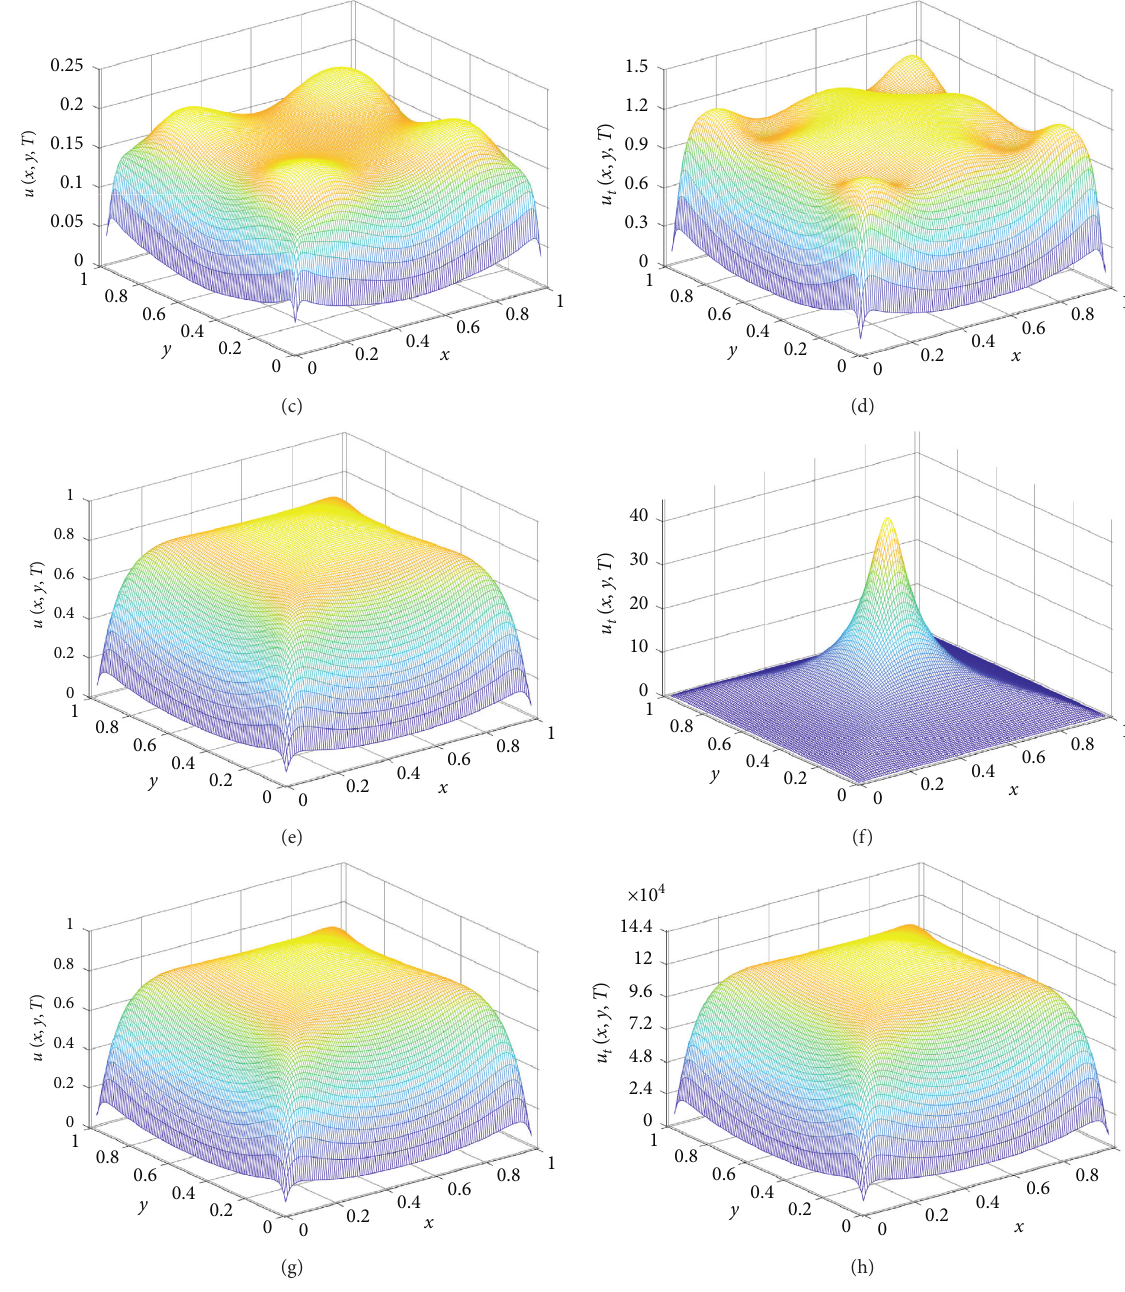
Figure 5: Numerical solution u ( x,y, T ) (a, c, e, g) and its temporal rate of change function u T � 1000 τ ≈ 0 . 00683013, 2000 τ ≈ 0 . 01366026 , 70455 τ ≈ 0 . 48121712, and 70485 τ ≈ 0 . 48142203, respectively. For the last pair of figures, we u ( x,y, T ) ≈ 0 . 99014166, max u ( x, y, T ) ≈ 1 . 44966641 × 10 5 . Again, boundary data are omitted for better have max t 0 ≤ x,y ≤ 1 0 ≤ x,y ≤ 1